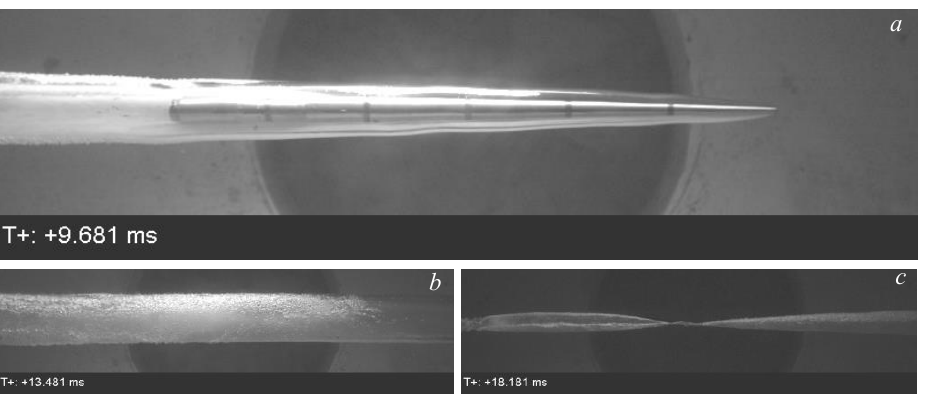
Fig. 2. Photos of underwater body movement